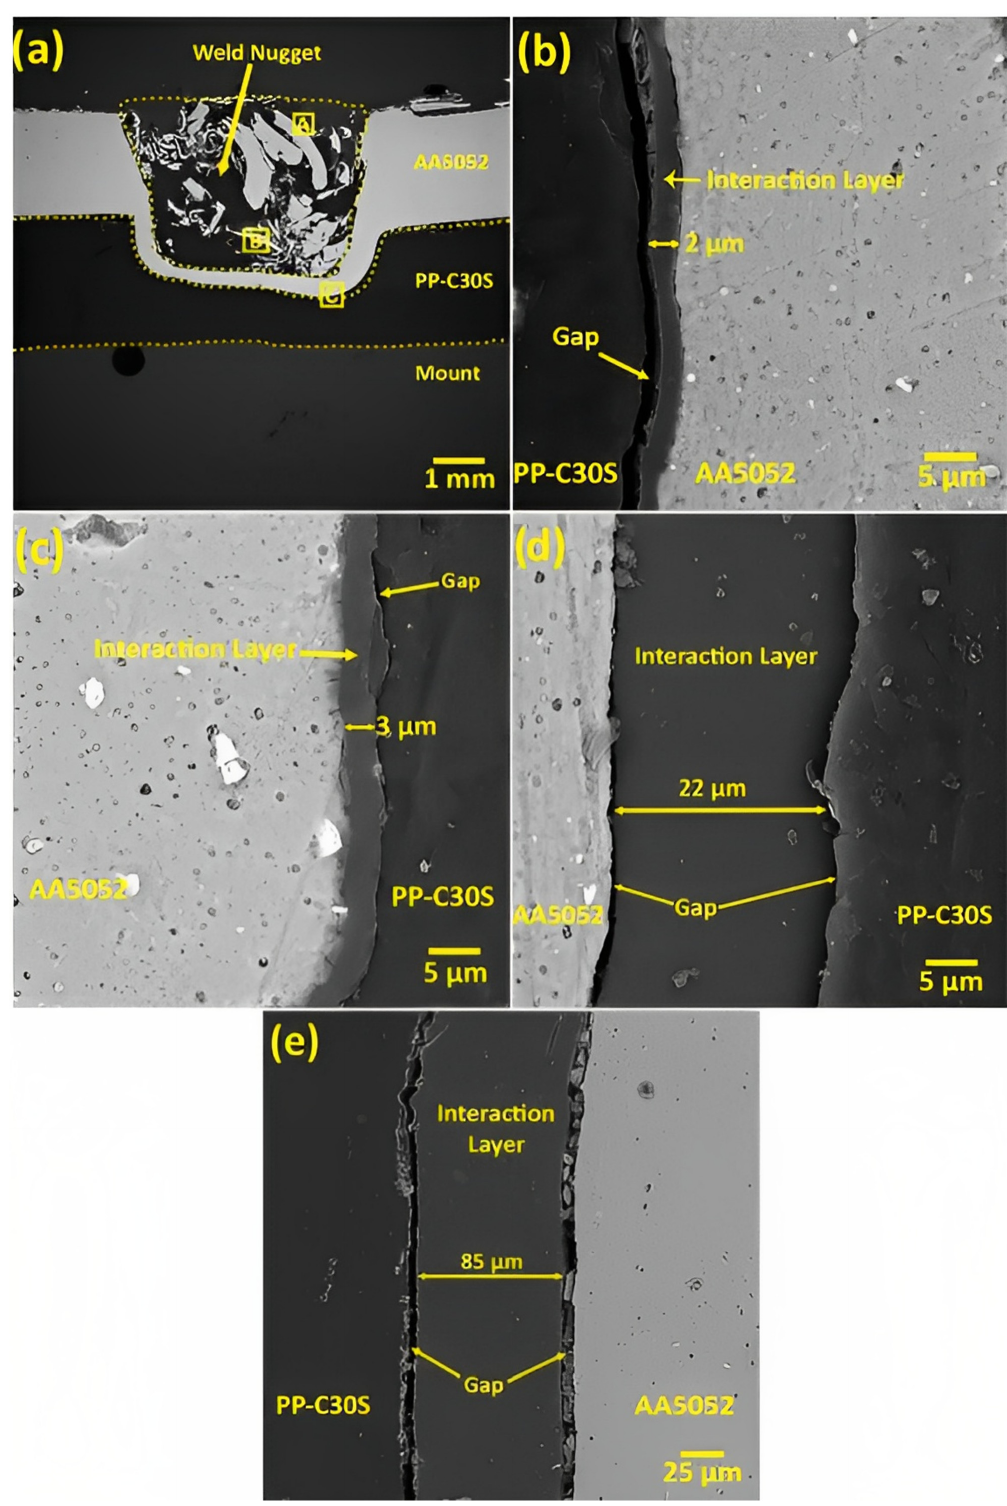
Figure 5. FE-SEM images of the metal/polymer interface at different regions: ( a ) cross-section and regions selected for investigation in the 800-70 specimen; ( b ) interaction layer at “region A”; ( c ) interaction layer at “region B”; ( d ) interaction layer at “region C”; and ( e ) interface of the polymer sheet and the weld nugget for the 1200-70 specimen. Reprinted with permission from Ref. [85]. 2016, Shahmiri et